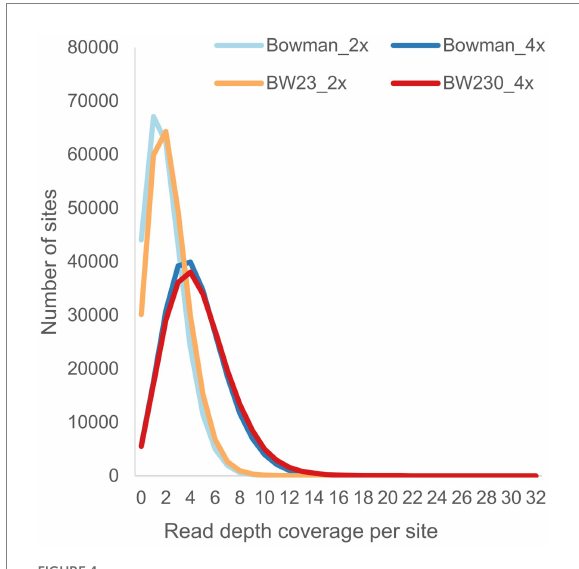
FIGURE 4 Read depth of the M3 individuals across the pre-called sites from the M2